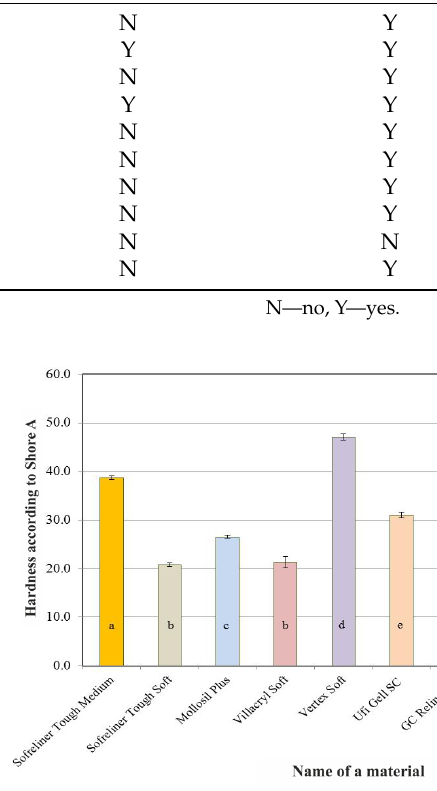
Figure 1. Average Shore A hardness values of the tested relining materials after 24 h of conditioning the samples in distilled water. The same letters denote mean values which do not differ statistically significantly. Table 2. Influence of the type of relining material used on the Shore A